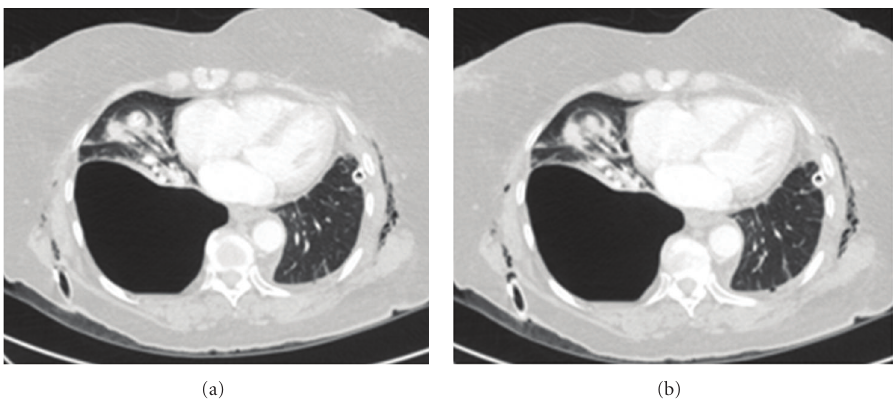
Figure 18: Axial CT scans on the same patient as in Figure 29 showing a large bulla in the right lower lobe associated with passive atelectasis in the right middle lobe. Note the surgical emphysema.